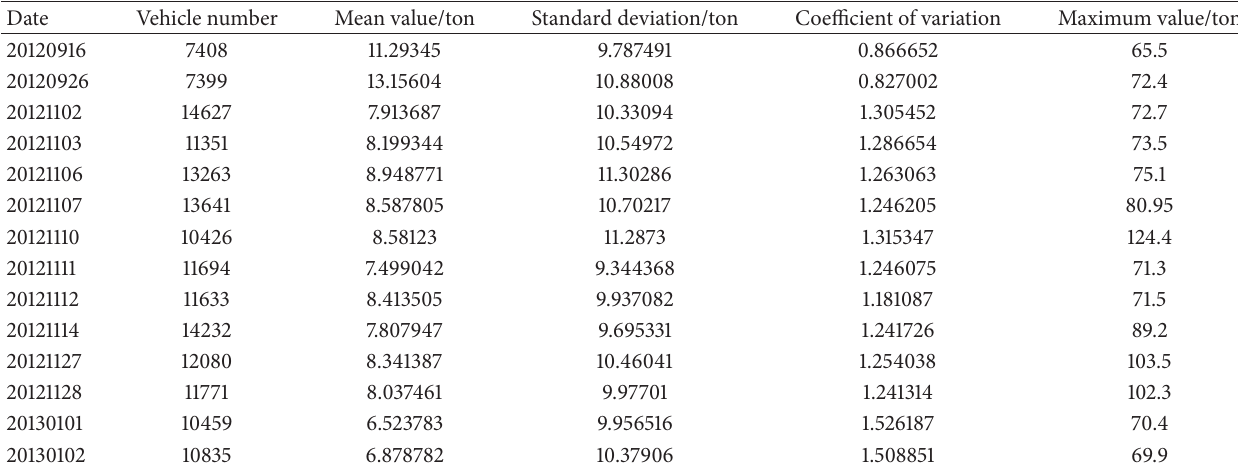
Figure 1: (a) Location of Hangzhou Bay Bridge. (b) Facade profile sketch map of the main towers of Hangzhou Bay Bridge. Table 1: Statistical characteristics of the vehicle